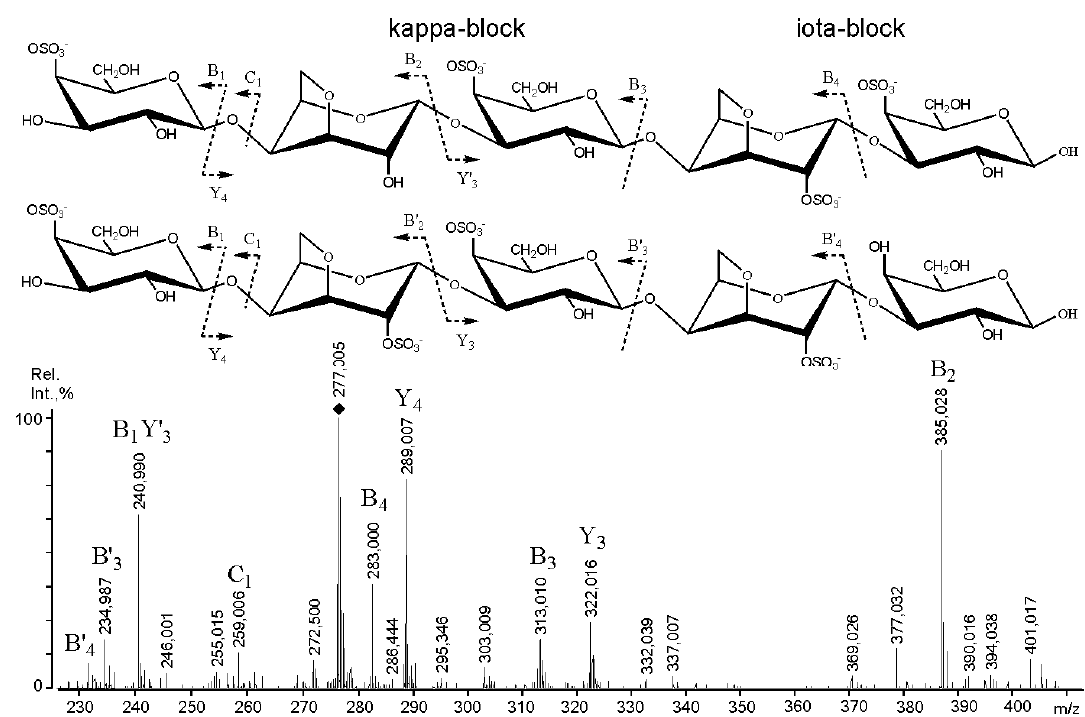
Figure 4. Negative-ion tandem ESIMS of ion at m/z 277.005, obtained through mild acid hydrolysis from RF-CRG.